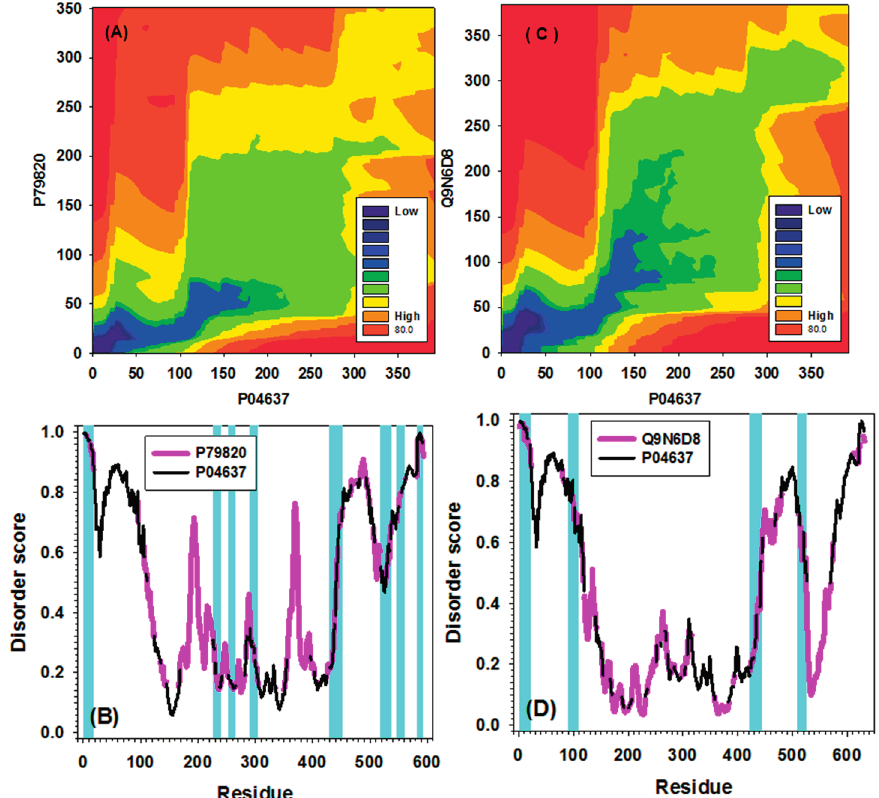
Figure 7 represents the results of the IDalign-based alignments of the disorder profiles of human p53 with its evolutionary distant homologues, p53 proteins from fish (UniProt ID: P79820) and fly (UniProt ID: Q9N6D8). In both cases, the resulting contour maps (Figure 7A,C), especially within the N-terminal regions of corresponding pairs, are asymmetric, with regions with darker colors that correspond to more similar sequence segments being located off-diagonal. Figure 7A,C also shows that there is another level of asymmetry, since the disorder-based similarity worsens while moving to the N- to the C-terminus, giving rise to the dark, off-diagonal, N-terminal regions and noticeably lighter, mostly on-diagonal, C-terminal regions. By using the outputs from the identified alignment paths, the original disorder curves were stretched and aligned (see Figure 7B,D). The highlighted short regions in Figure 7B,D correspond to sequence segments characterized by similar patterns of the disorder distribution. As expected, the number of these similar patterns is lower in more distant human-fly pair. The corresponding traditional sequence alignments are shown in Figure S1.